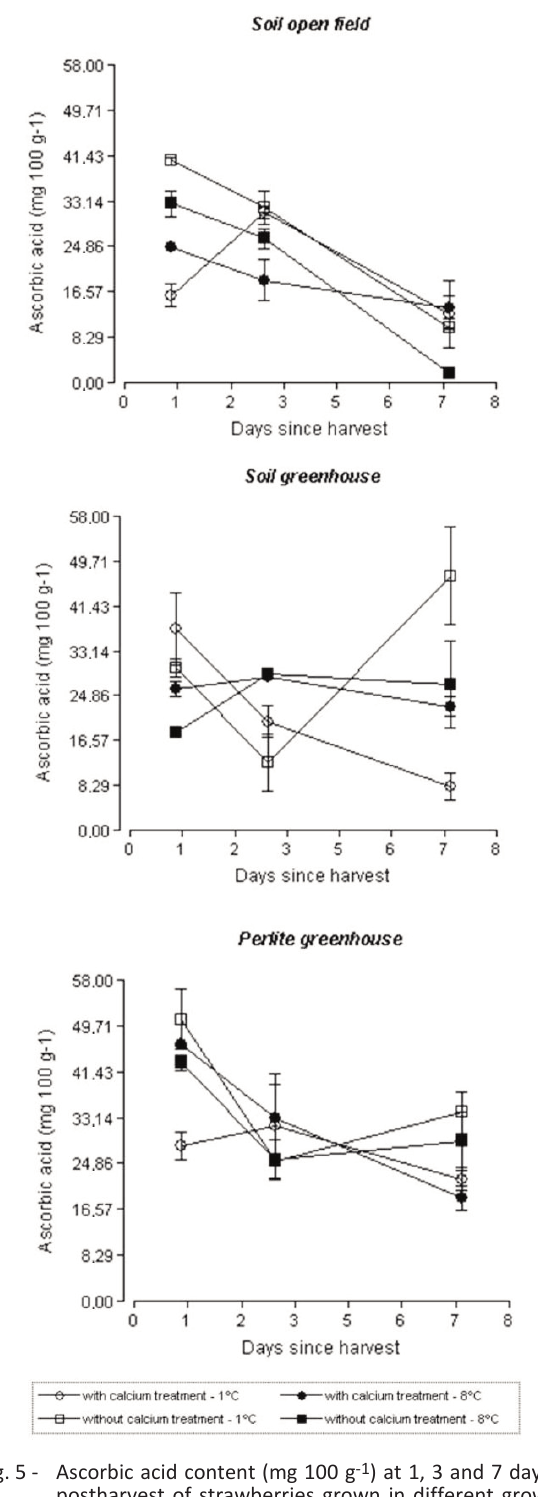
Fig. 5 - Ascorbic acid content (mg 100 g -1 ) at 1, 3 and 7 days of postharvest of strawberries grown in different growing systems, calcium lactate treatment and two storage